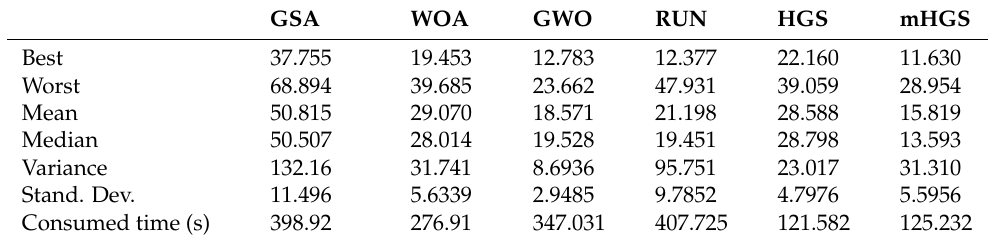
Table 6. Statistical parameters of different optimizers applied to the IEEE 33-bus.